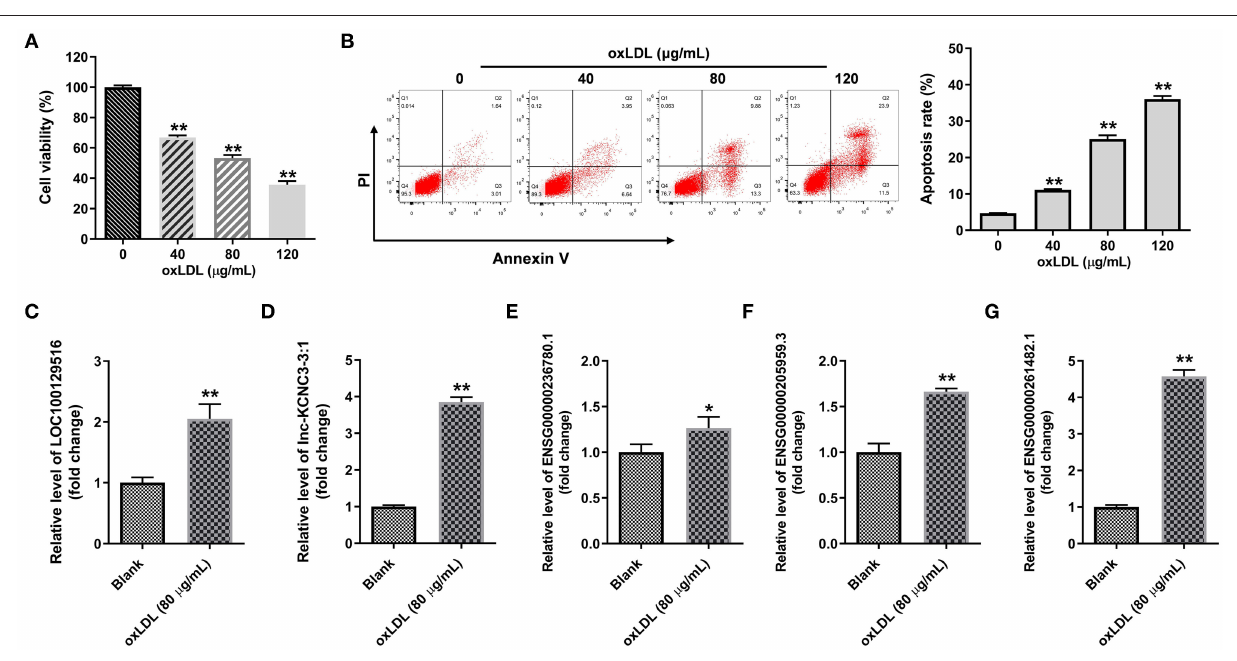
Frontiers in Cardiovascular Medicine | www.frontiersin.org